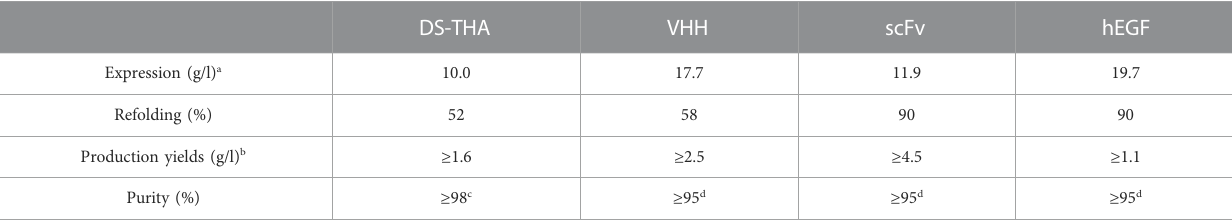
TABLE 1 Characteristics of Switchtag-based production for the disul fi de bond containing pepteins.